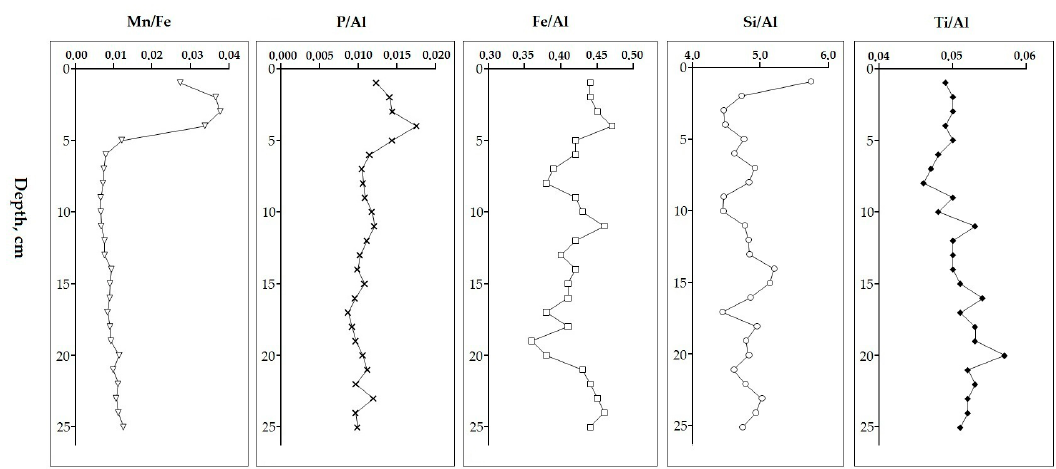
Figure 11. The elemental ratios down the core AMK-5432, the Bear Island Trough. Dotted line means element ratio's average for the core.